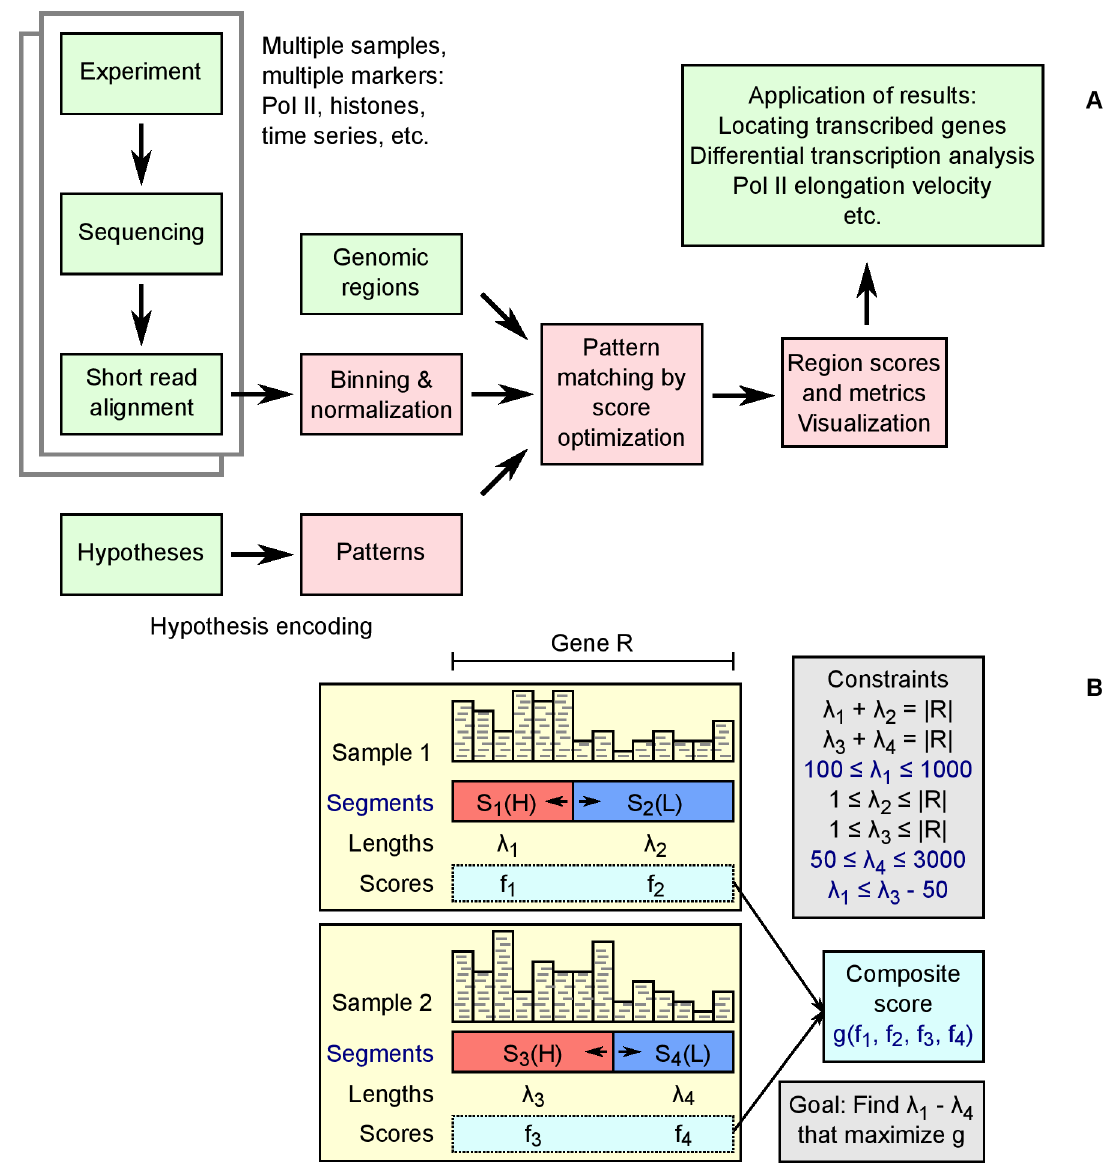
Figure 1. (A) Schematic workflow of SPINLONG. Red and green boxes denote implementation of SPINLONG and input from a user, respectively. SPINLONG produces tabulated and graphical results that can be interpreted in the context of the hypotheses. (B) Illustration of the pattern matching step with two samples and four segments in the context of a gene R . User-provided information is shown with blue labels. Short reads (gray) for each sample are assigned into fixed length bins and bin counts are normalized. A user-defined pattern describes the expected spatial distribution of bin counts in the samples, formulated by dividing each sample into one or more segments ( S i ). Segment classes H and L indicate whether the segment is expected to contain a ‘‘high’’ (red) or ‘‘low’’ (blue) amount of short reads, respectively. The user defines the segment divisions and their classes, while nonlinear optimization is used to assign segment lengths ( l i ) by maximizing score function g and taking into account linear constraints. The composite score g is composed of segment scores f i , which are computed based on bin counts and segment lengths. Constraints include structural constraints, such as the requirement that segment lengths of a sample sum up to gene length D R D , as well as custom constraints (blue).